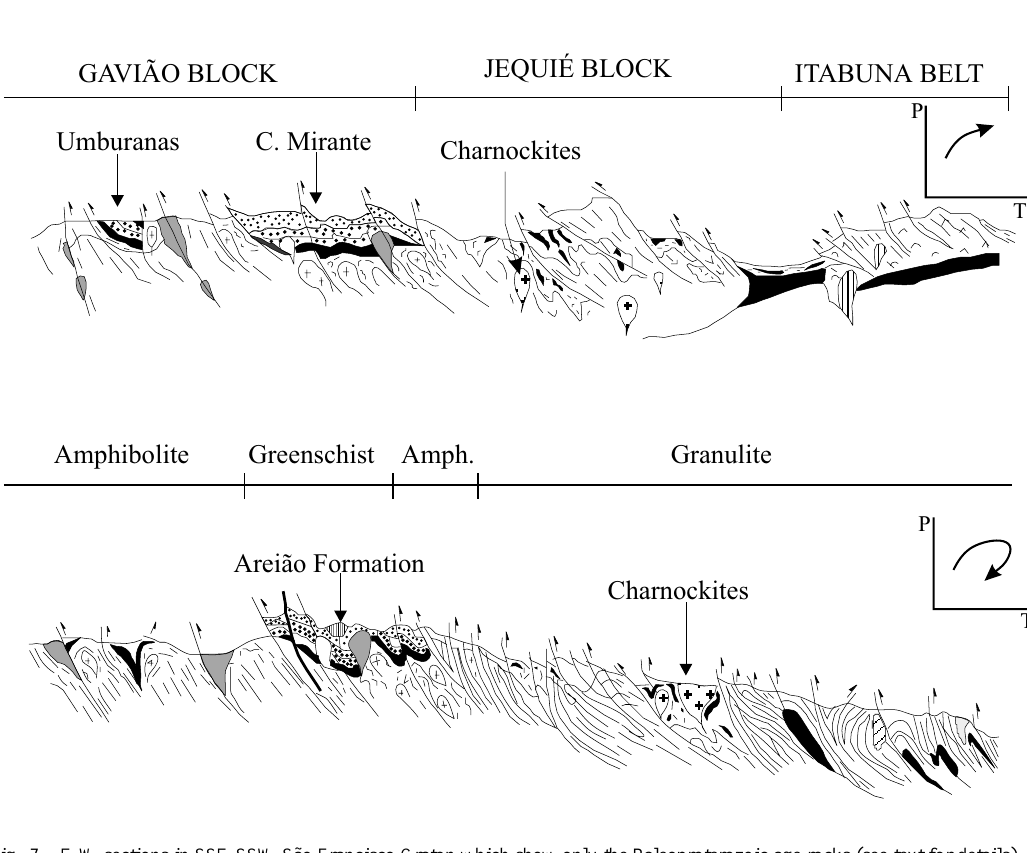
Fig. 7 – E-W sections in SSE-SSW São Francisco Craton which show only the Paleoproterozoic age rocks (see text for details). (a) intermediate Transamazonian collision stage with the last siliciclastic sediment deposition in the Umburanas and Contendas Mirante Greenstone Belts, and the onset of charnockite production in Brejões region. (b) Present situation with Itabuna Belt (granulites), obduction over the Jequié Block and this one over the Gavião Block (amphibolite and greenschist metamorphic rocks). On the right-hand side of each cartoon, PTt diagrams are shown related to the study of the aluminum-magnesian